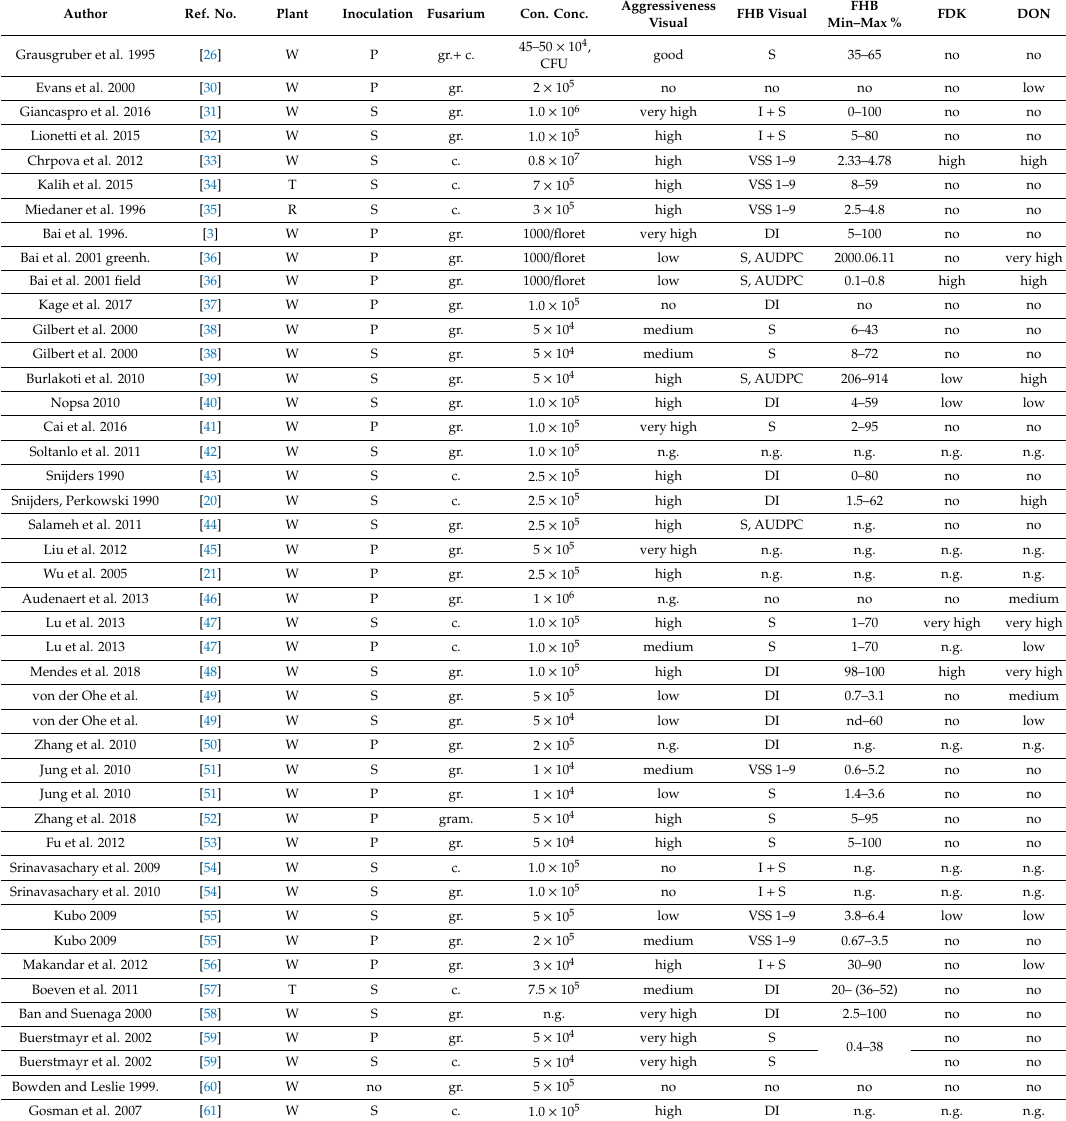
Table 1. Experimental data of Fusarium resistance and pathogenicity tests from papers using one single